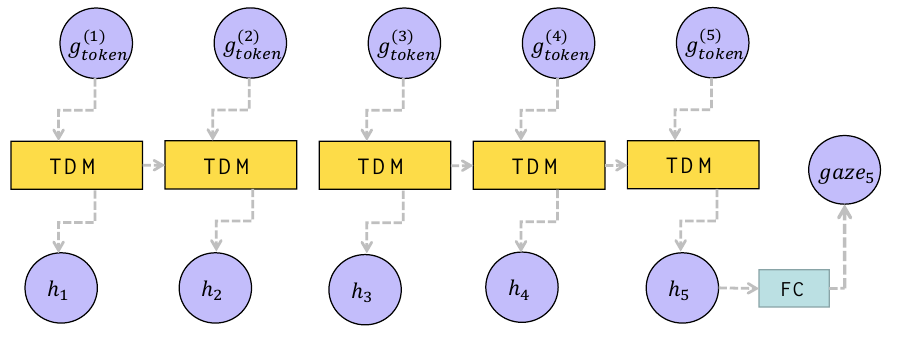
Figure 5. The structure of the temporal dynamic